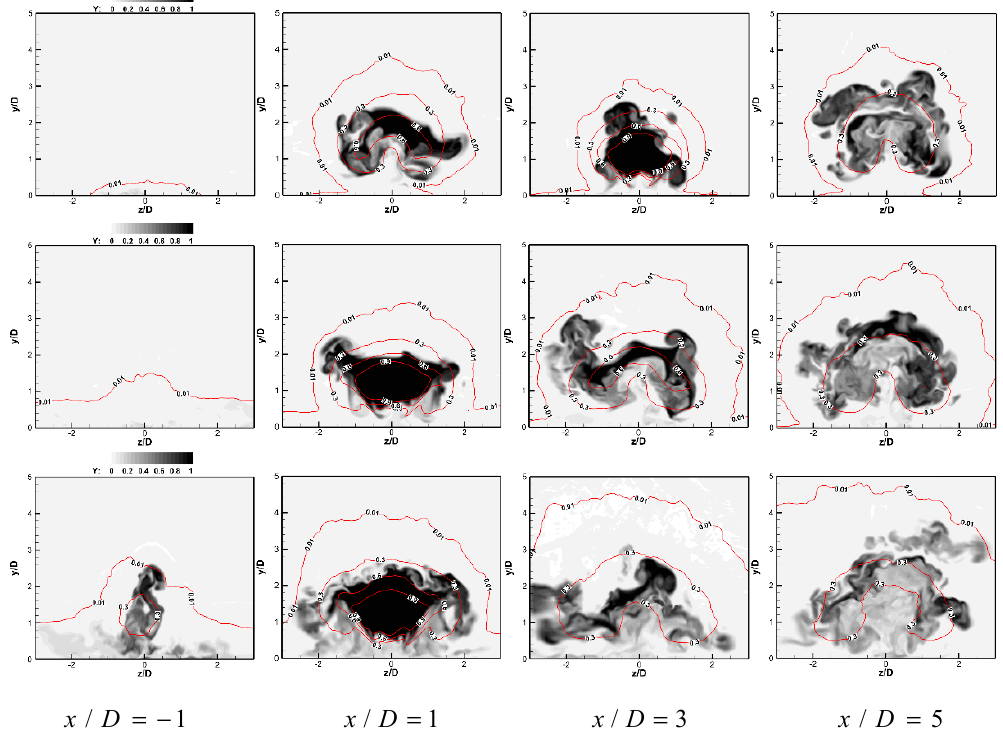
Figure 15. The instantaneous mixture fraction at downstream positions x / D = − 1, 1, 3, and 5 overlapped with the time-averaged mixing fraction isoline.